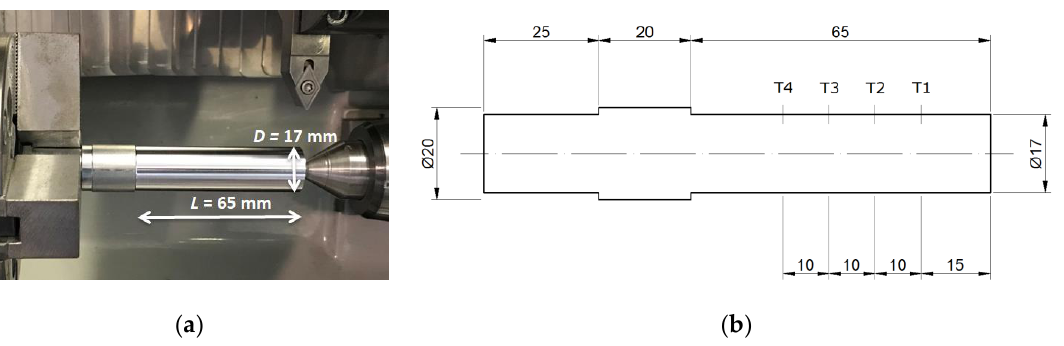
Figure 1. ( a ) Sample geometry; ( b ) measurement area (all dimensions in mm).